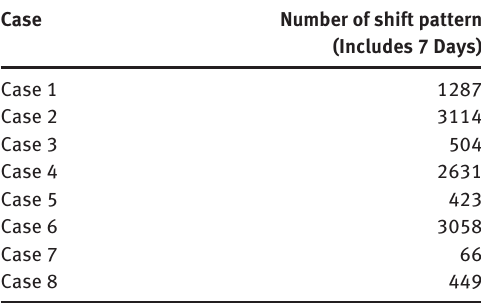
Table 6: Number of Feasible Shift Pattern for All Cases.